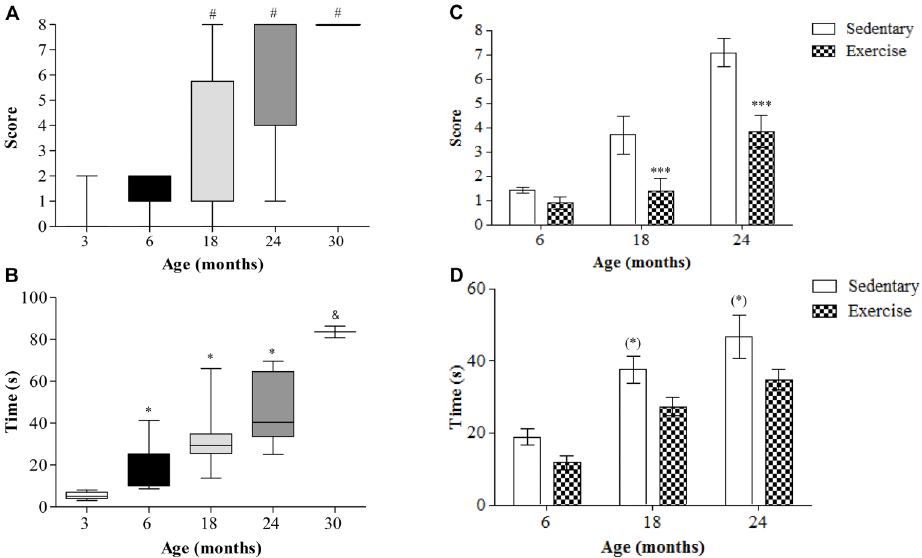
Figure 6. Responses to balance beam test in terms of total score ( A , C ) and total time to traverse the beam ( B , D ) for Wistar rats of different ages ( A , B ) and after 12 weeks of treadmill running ( C , D ). Data are reported as medians and 10 – 90% interquartile ranges ( A , B ) and means ± SE ( C , D ). # P o 0.05 compared to 3- and 6-month-old rats; ***P o 0.05 compared to sedentary rats over the same age; *P o 0.05 compared to 3-month-old rats; ( * ) P o 0.05 compared to 6-month-old rats; & P o 0.05 compared to all groups ( A and B ,